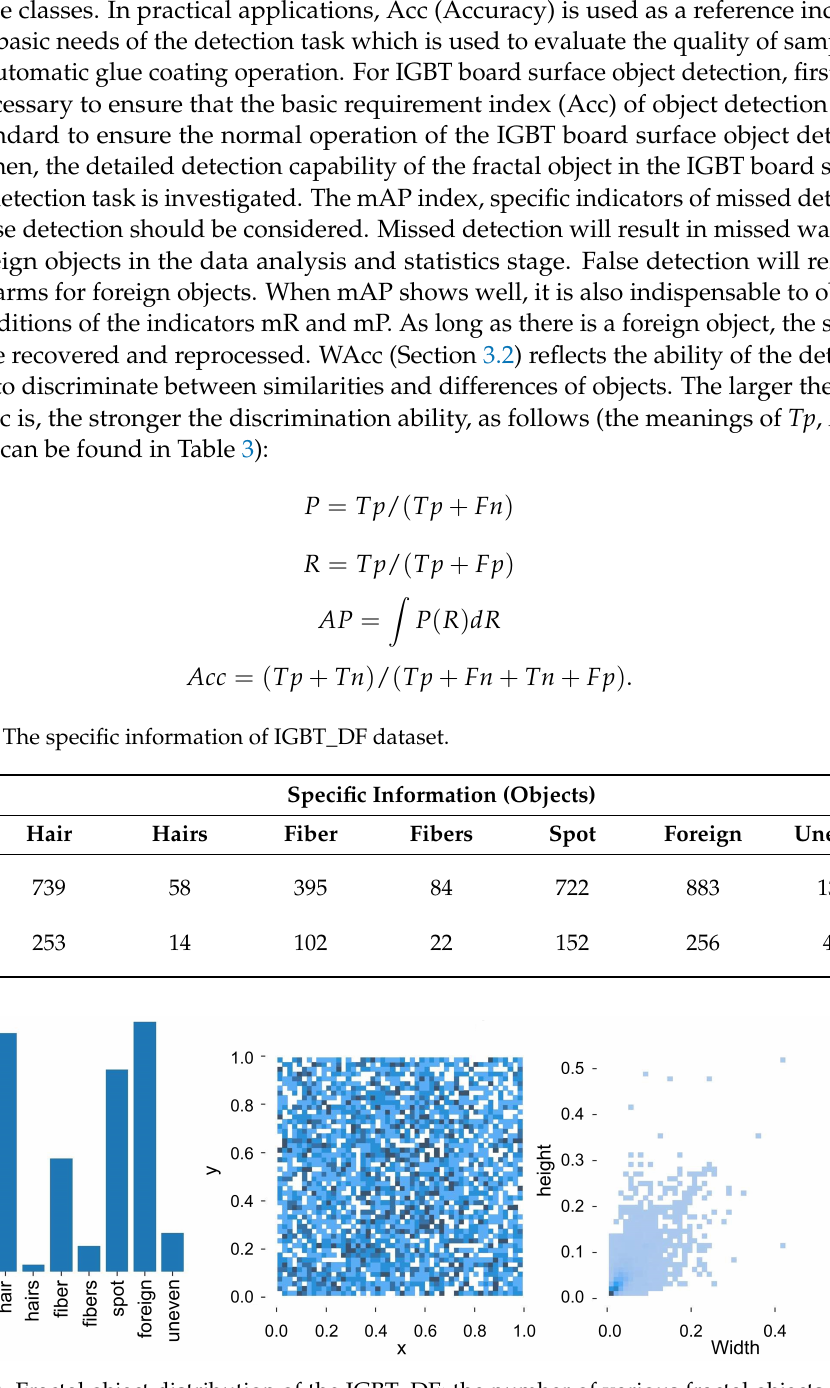
Figure 9. Fractal object distribution of the IGBT_DF: the number of various fractal objects ( left 1 ), the position of the fractal object in the picture ( right 2 ), and the size of the fractal object ( right 1 ). Table 3. Basic indicators for